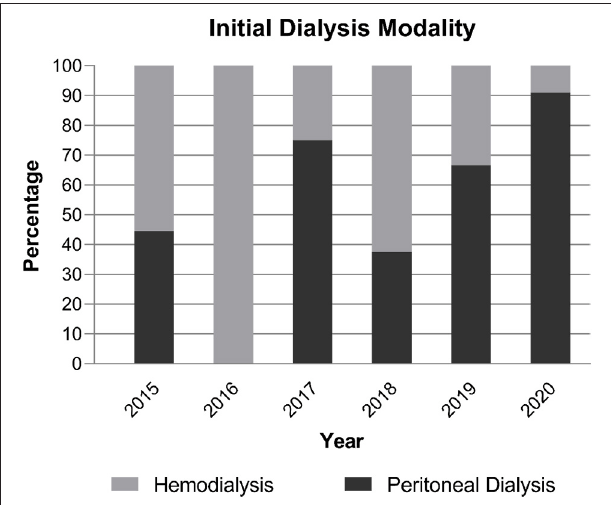
FIGURE 2 | Initial dialysis modality used for pediatric patients in our center from 2015 to 2020.